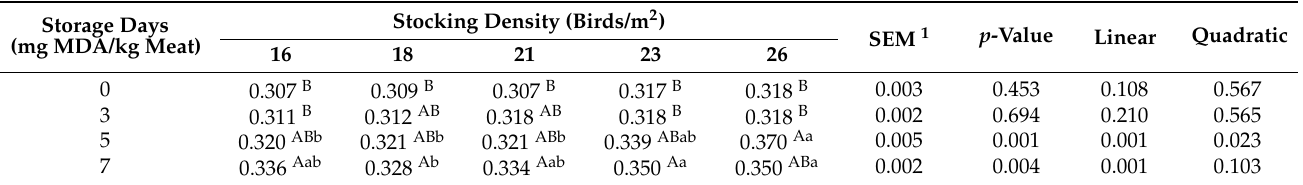
Table 5. Effects of stocking density on breast meat quality of broiler chickens under high